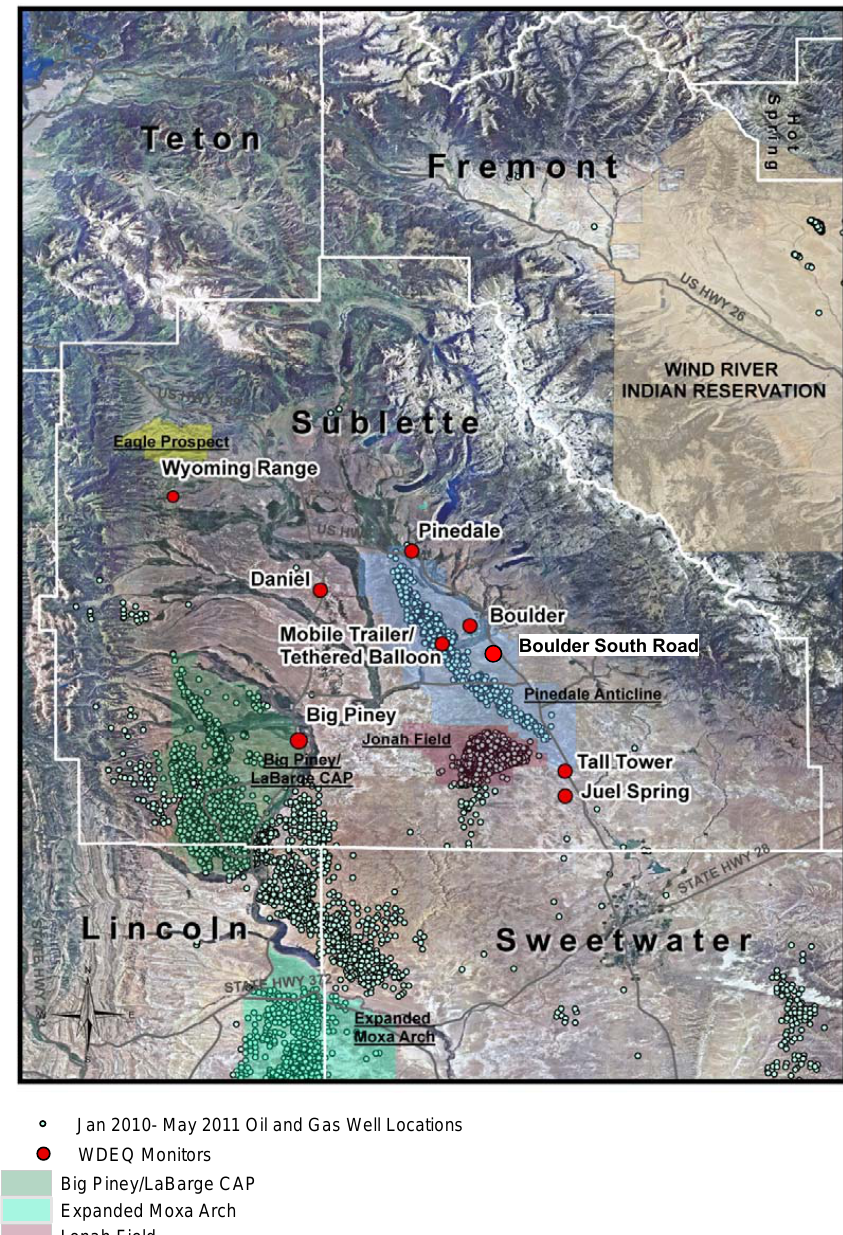
Figure 1. The monitoring sites Boulder, Boulder South Road, Tethered Balloon, Tall Tower and other WDEQ (Wyoming Department of Environmental Quality) monitoring sites relative to the locations of oil- and gas-well locations operating during the period January–March